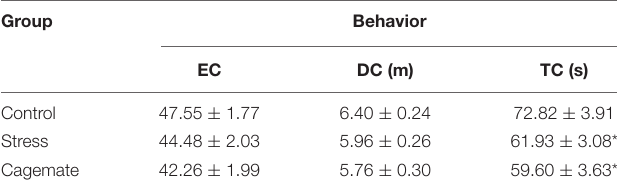
TABLE 4 | Behaviors evaluated in the open field test.